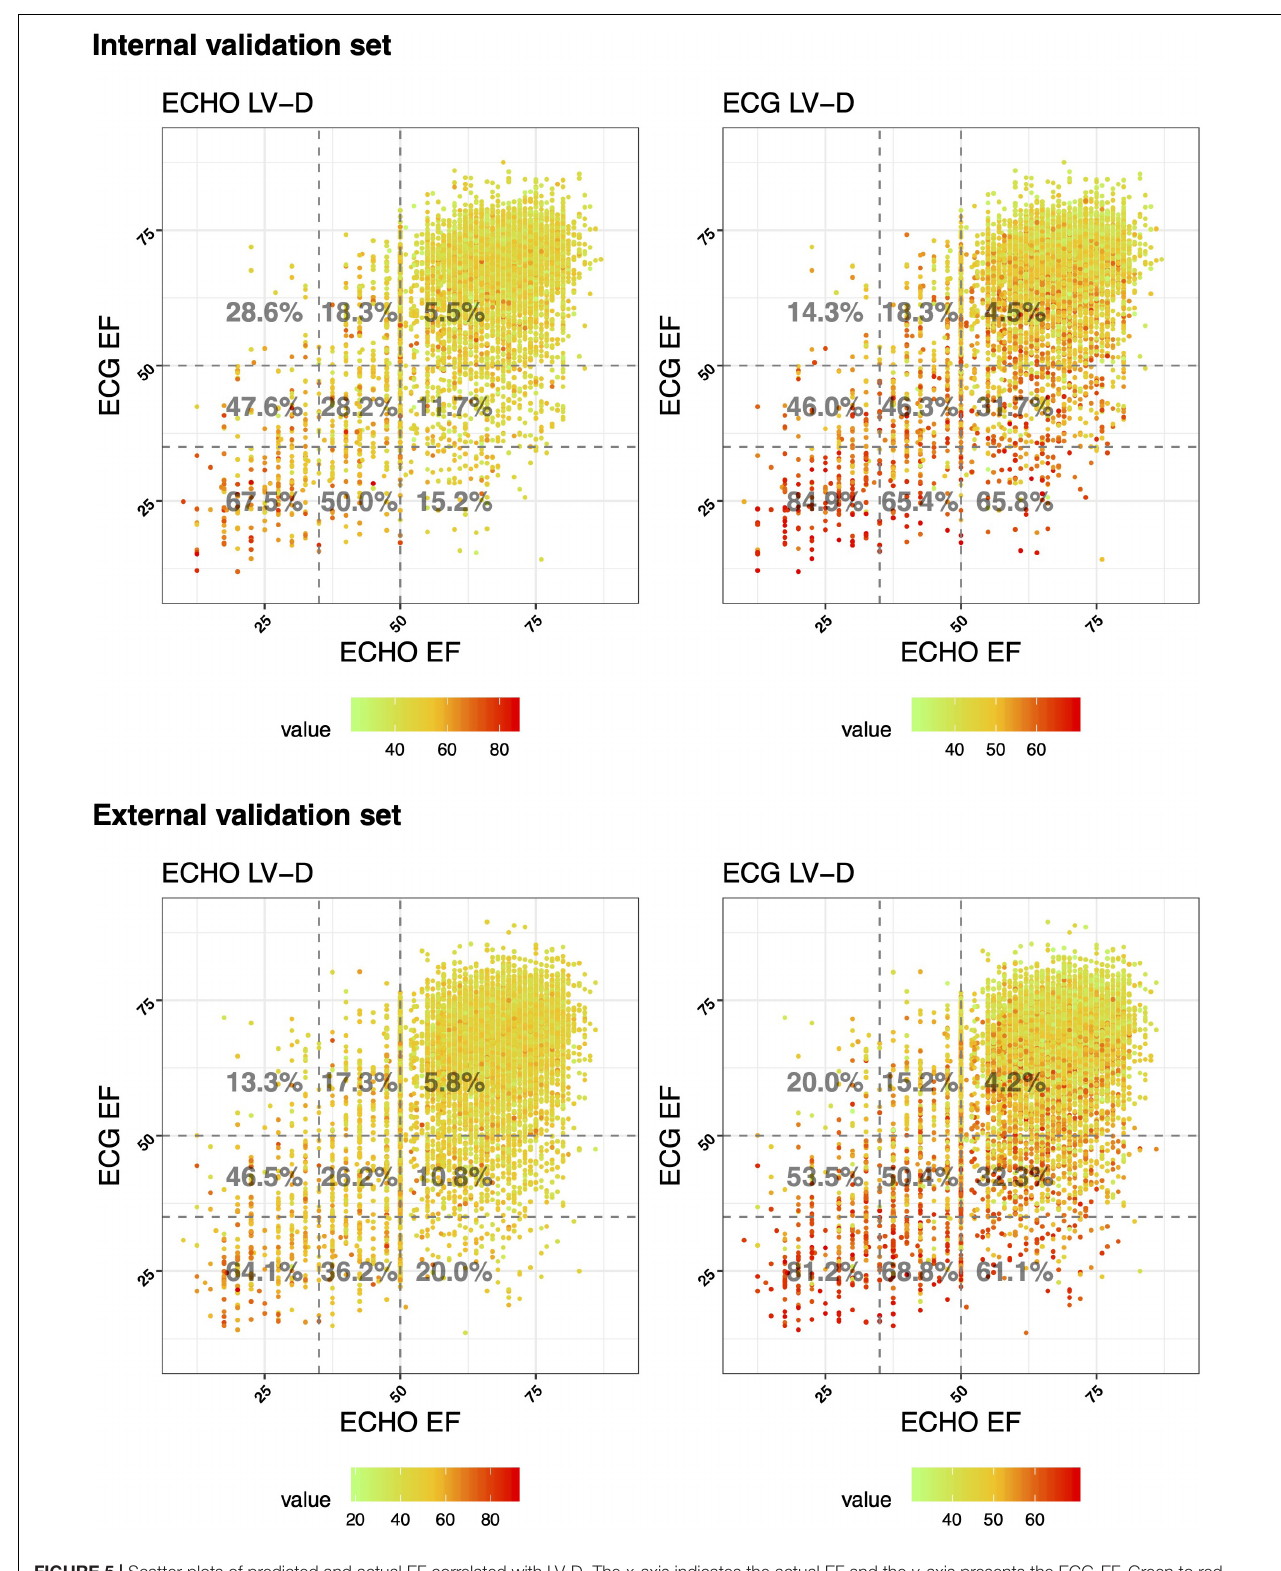
FIGURE 5 | Scatter plots of predicted and actual EF correlated with LV-D. The x -axis indicates the actual EF and the y -axis presents the ECG-EF. Green to red points represent the small and large predicted and actual LV-D, respectively. The percentages were the proportion of people with an ECHO/ECG LV-D > 56 mm in each ECHO and ECG EF